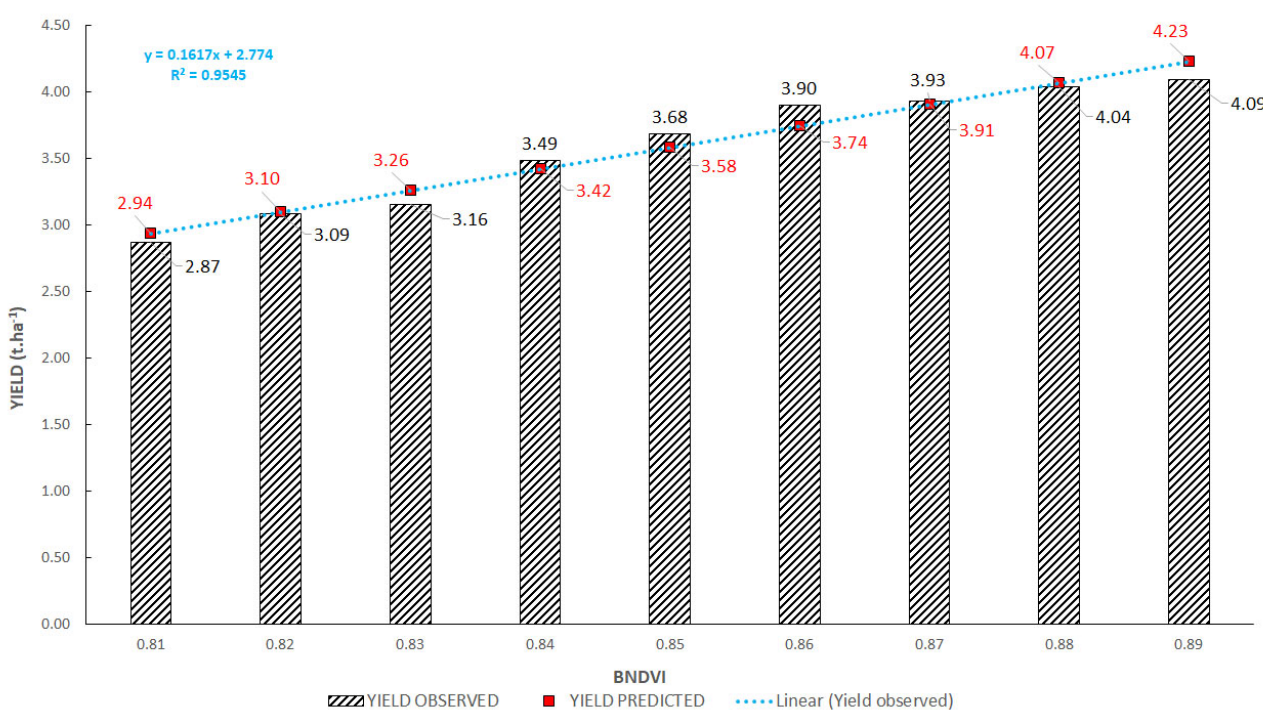
Figure 11. Graph of linear dependence of yield on NDVI. Model shows yields observed and yields predicted based on the regression analysis of NDVI and yields achieved.